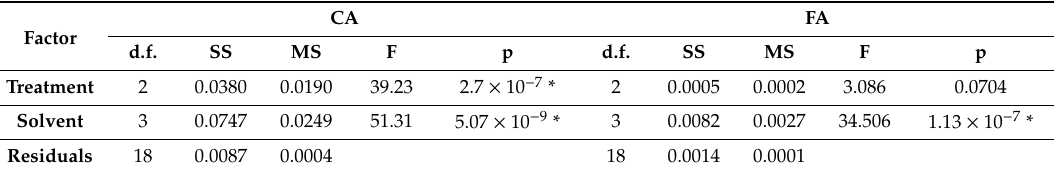
Table 3. ANOVA parameters to the significant e ff ects on FA and CA extraction depending on treatment and solvent (CA and FA measurements realized in duplicate for each